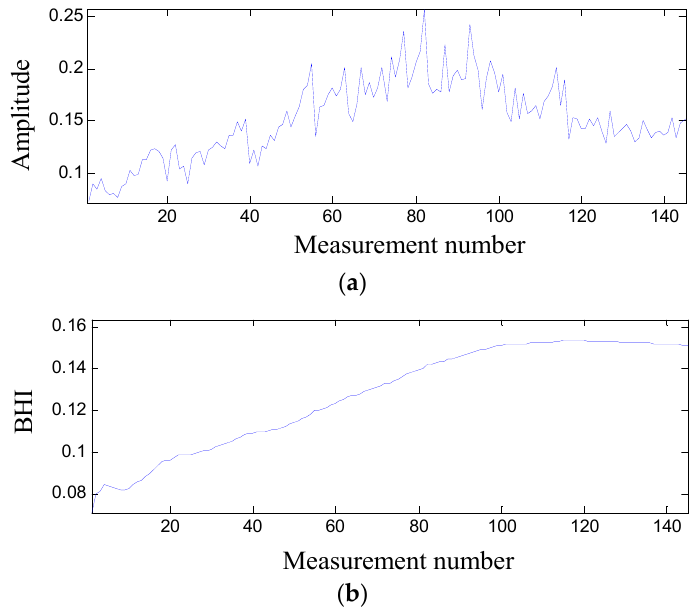
Figure 4. Bearing degradation assessment: ( a ) the RMS after applying the high-pass filter; ( b ) the degradation trend generated by the BHI.